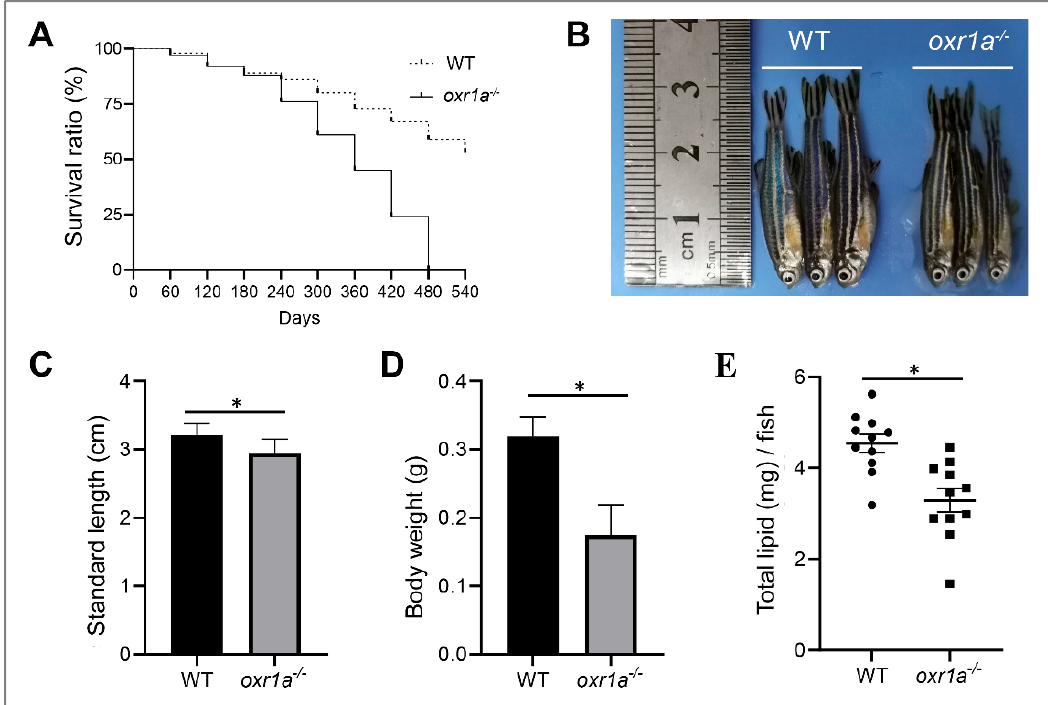
Figure 4. Oxr1a − / − mutant zebrafish reduced lifespan and impacted physique. ( A ) The survival curves of WT and oxr1a − / − mutant zebrafish were depicted by Kaplan–Meier assay, n = 100 zebrafish in each group. The morphology ( B ); standard length ( C ); and body weight ( D ) were measured in both WT and oxr1a − / − mutant zebrafish at 14 months old. ( E ) The total lipid content was tested and compared between WT and oxr1a − / − mutant zebrafish by the Folch method. * indicates significant differences ( p < 0.05).